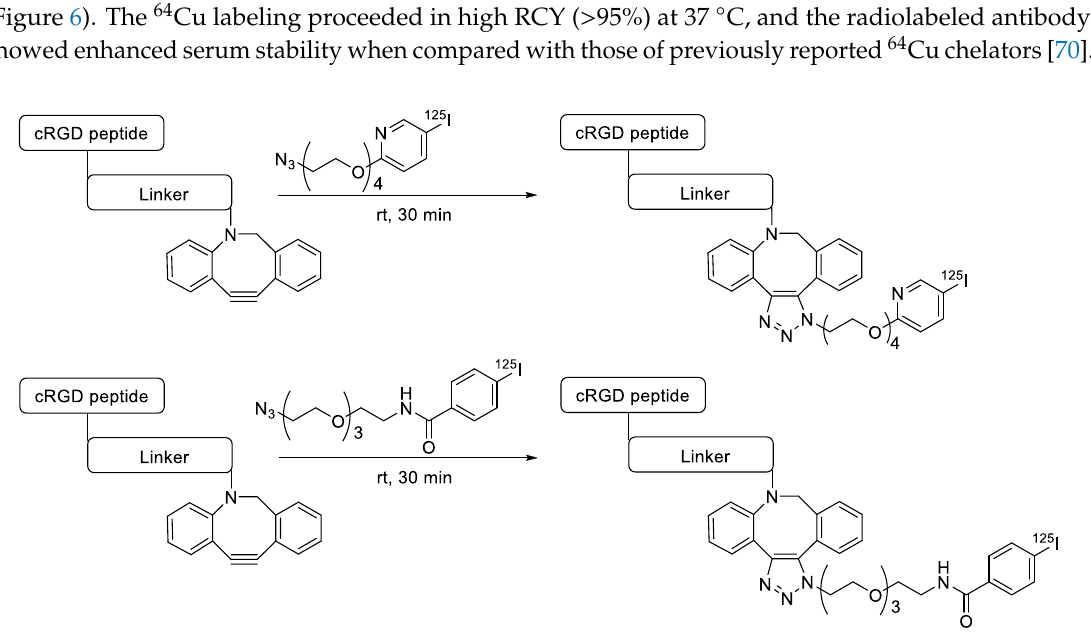
Figure 5. Radiolabeling of DBCO-conjugated cRGD peptide using 125 I-labeled azide tracers.